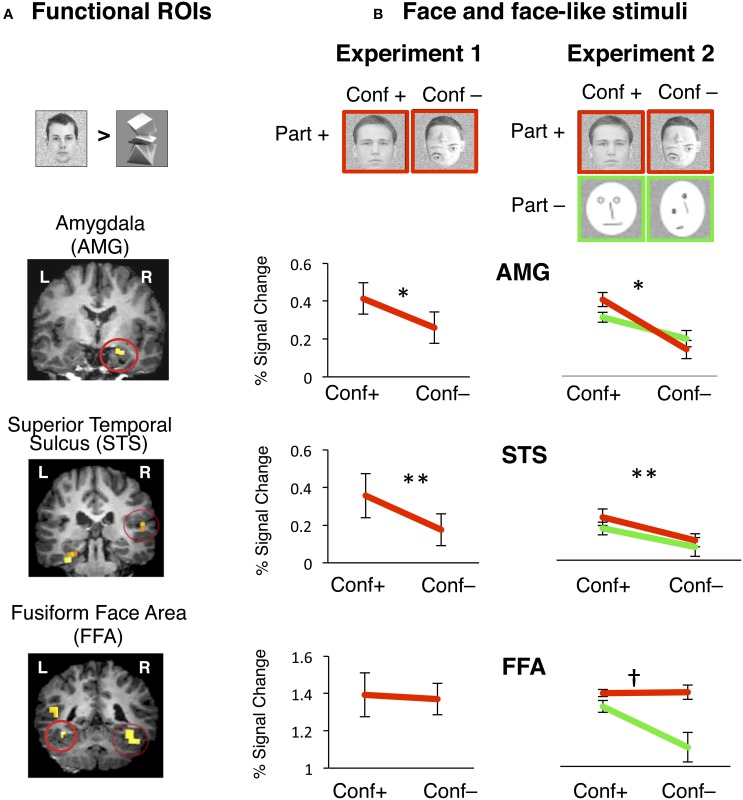
Face selective functional ROIs were defined using data from one experiment and signals were extracted during an independent experiment. (A) Face selective ROIs in the AMG, posterior STS and FFA were defined by the contrast of natural faces > novel objects, P < 0.001. Examples of individual t-maps with this contrast are overlaid on coronal slices of high-resolution T1 volume from a representative participant. Functional ROIs are high-lighted by a red circle. (B) During Experiment 1, visual stimuli included natural faces with the normal configuration of face parts (“conf +”) and face-like stimuli where internal parts were randomly rearranged within the face boundary (“conf –”). During Experiment 2 visual stimuli included face-like images that retained the natural appearance of face parts (images with red outline, “parts +”) or to face-like schematics (green out line, “parts –”). Each type of stimulus was presented either by retaining the 1st order configuration of internal face parts (“conf +”), or random rearrangement of internal parts (“conf –”). Independent analysis of response amplitudes during Experiment 1 to face-like stimuli in the right hemisphere from face-selective regions of AMG, STS, and FFA. Red lines show response amplitudes to face stimuli that retained the 1st order configural information (“conf +”) and stimuli with internal parts randomly rearranged (“conf –”). Error bars show ± SEM. Right AMG: Removal of configural information significantly reduced response amplitudes in the right AMG. *conf:
p = 0.03, n = 7. Right STS: Removal of configural information significantly reduced response amplitudes in the right STS. **conf:
p = 0.0001, n = 6. Right FFA: Removal of configural information did not reduce response amplitudes in the right FFA in the presence of part information. n = 8. Independent analysis of response amplitudes during Experiment 2 to face-like stimuli in the right hemisphere from face-selective regions of AMG, STS, and FFA. Red lines show response amplitudes to face stimuli that retained natural part information (“part +”). Green lines show response amplitudes to schematic faces (“part –”). Responses to face stimuli are plotted for the subtypes that retained the 1st order configural information (“conf +”) and stimuli with internal parts randomly rearranged (“conf –”). Error bars show ± SEM. Right AMG: Removal of configural information significantly reduced response amplitudes in the right AMG in the presence (red line) or absence (green line) of part information. *conf:
p = 0.01, n = 7. Right STS: Removal of configural information significantly reduced response amplitudes in the right STS in the presence (red line) or absence (green line) of part information. **conf:
p = 0.0001, n = 6. Right FFA: Removal of configural information did not reduce response amplitudes in the right FFA in the presence of part information (red line), but did so in the absence of part information (green line), revealing a significant interaction between factors of part and configural information. †conf X part:
p = 0.007, n = 8.